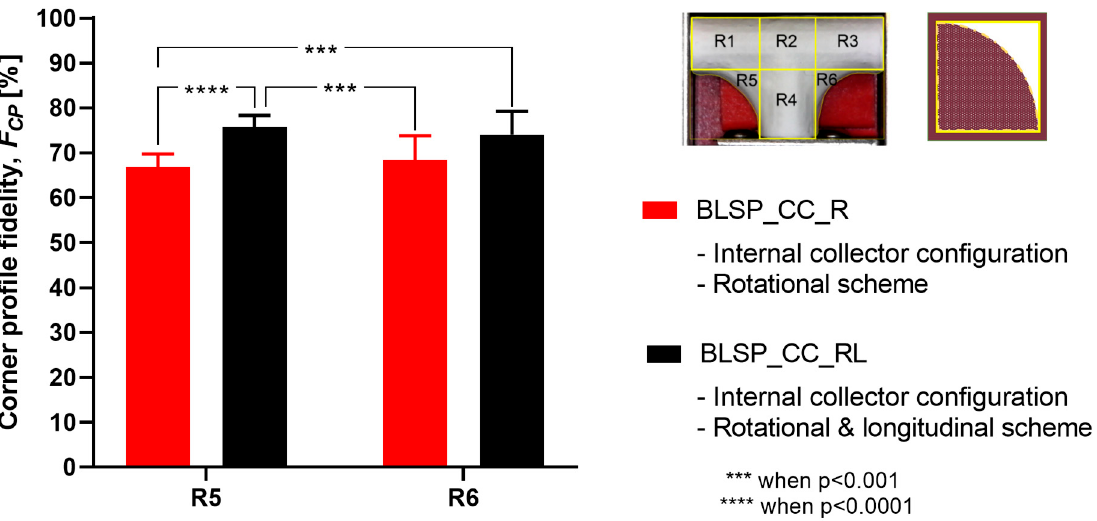
Figure 15. Average corner profile fidelity at regions R5 and R6. (A two-way ANOVA showed that the motion scheme with rotational and longitudinal approach increased the corner profile fidelity).